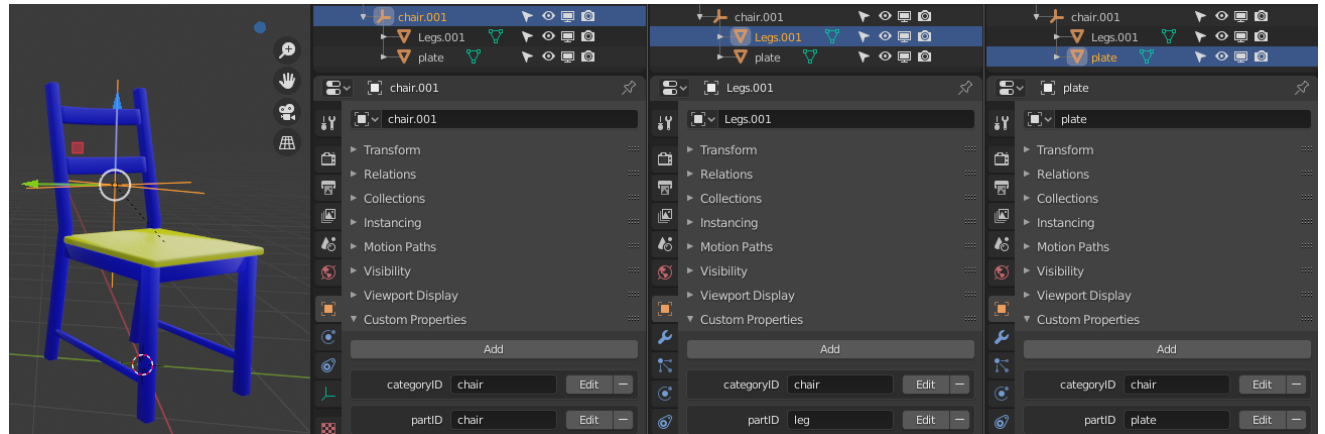
Figure 9. The screenshots show the approach to mark different objects and their components for classification by the add-on. All parts of the same object or object group (here: chair ) get the same categoryID . To distinguish the parts, the attribute partID is used.